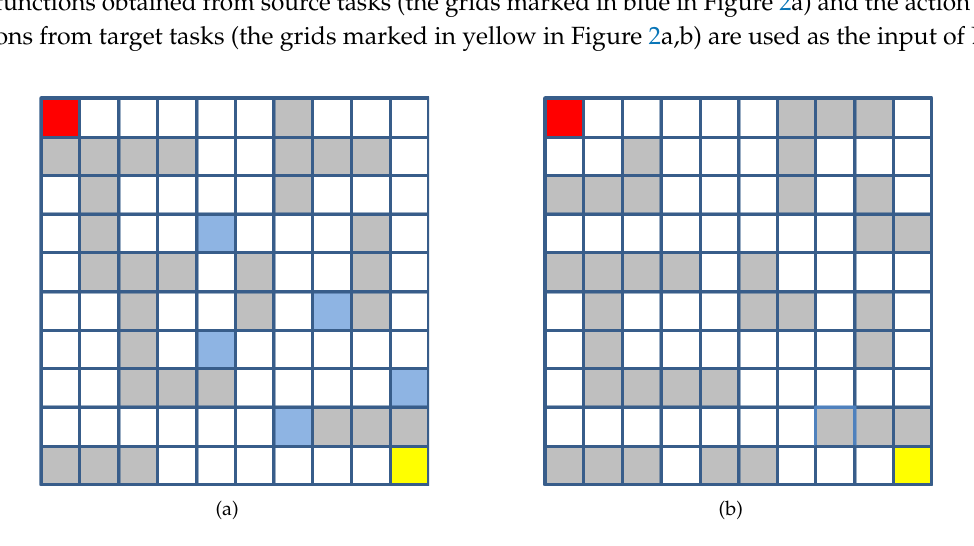
Figure 2. The maze navigation environments of two different settings. The red, yellow and gray grids in the figure denote respectively the starting positions, the target positions, and the obstacles. The goal of the agent is to walk from the start point (the red grids) to the target point (the yellow